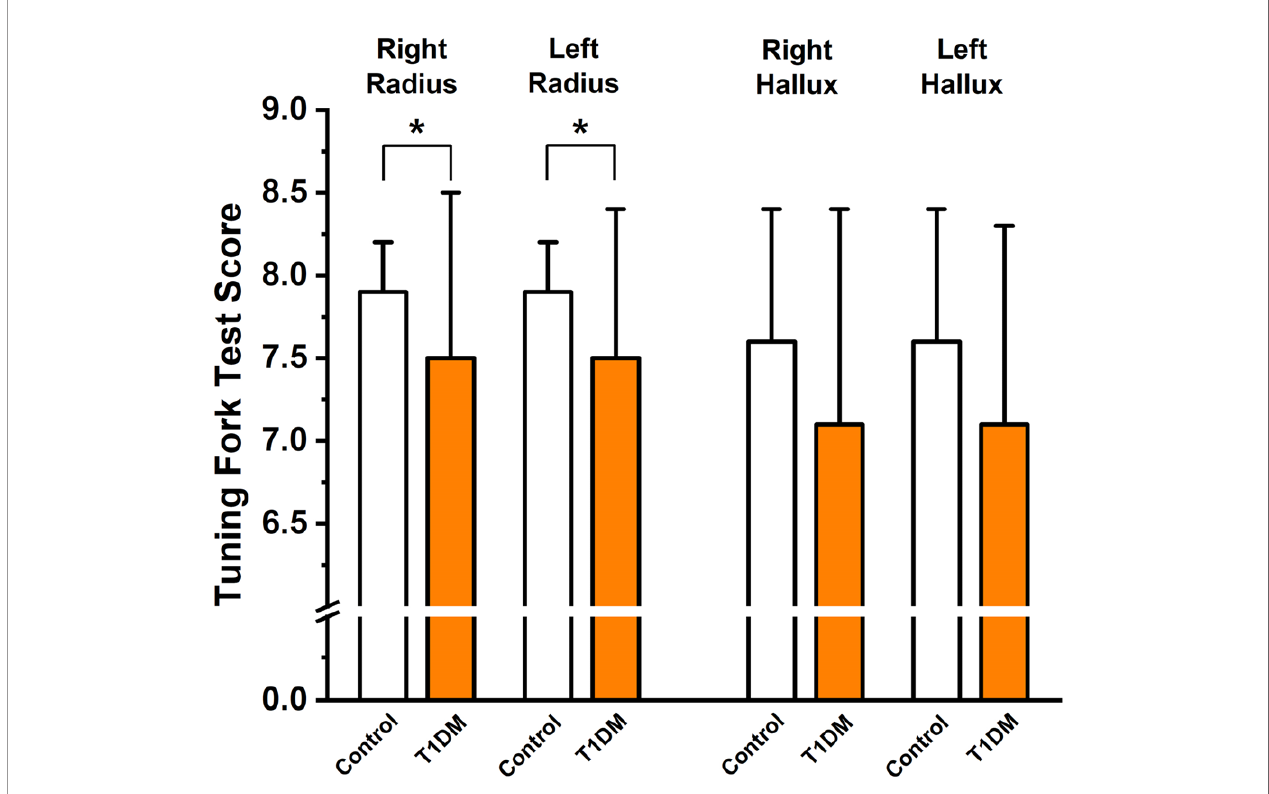
FIGURE 2 | Peripheral sensory function testing using the 128 Hz Rydel-Seiffer graduated tuning fork on the distal end of right (RR), left (LR) radius, and the right (RH) and left (LH) hallux in the control group and in type 1 diabetes mellitus (T1DM) patients; *p<0.05 vs. control group; n=30 and 29 individuals in the control and T1DM groups,